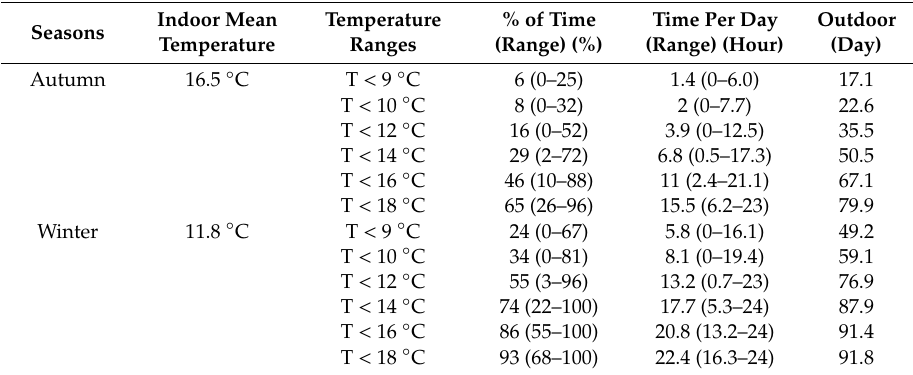
Table 2. Autumn and winter time related to di ff erent ranges of mean indoor temperatures of the 16 sample houses in Minginui, Te Whaiti and Murupara.